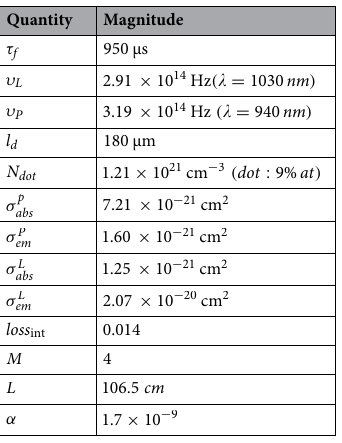
Table 1. The values of parameters that were used in the numerical analysis.